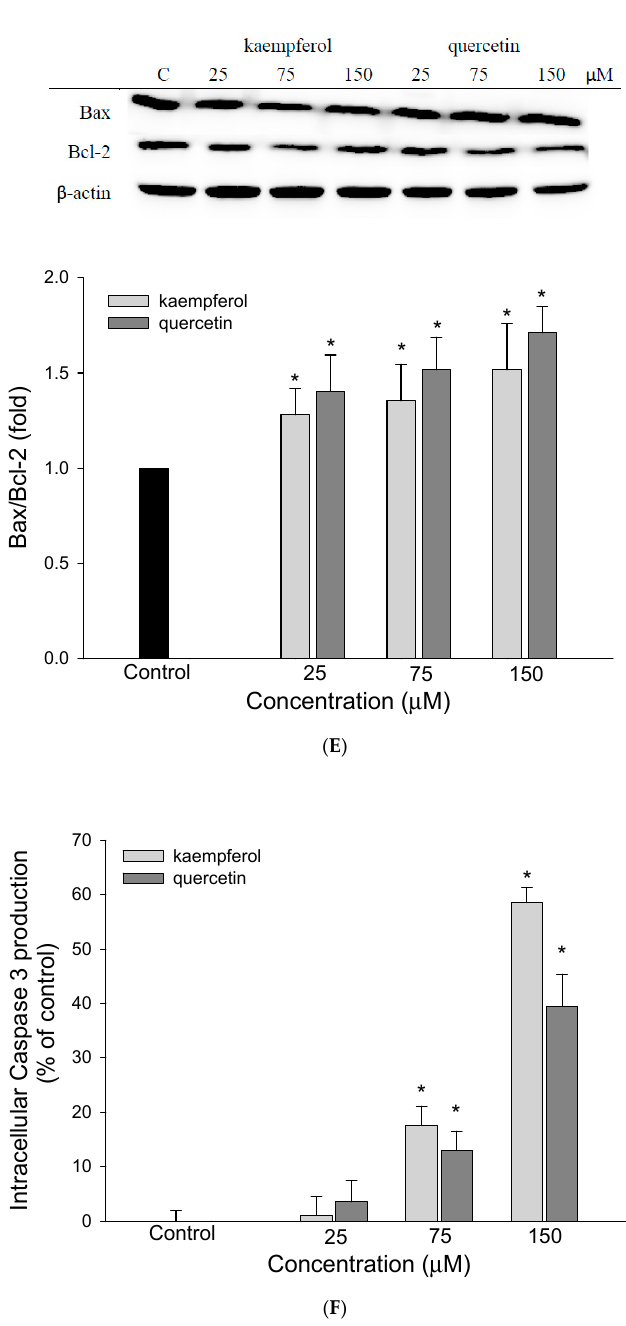
Figure 4. The effect of kaempferol and quercetin on cell viability and apoptotic effect of HepG2 cells. ( A ) Effect of kaempferol or quercetin on cell viability was determined by MTT assay. ( B ) Effect of kaempferol or quercetin on cell disruption was determined by lactate dehydrogenase (LDH) leakage assay. The results are expressed as percent of LDH activity in the culture medium relative to the total enzyme activity. ( C ) Chromatin condensation was determined by DAPI staining after kaempferol or quercetin treatment. The DAPI-stained cells were evaluated using fluorescence microscopy (200 × ). The arrow indicated apoptotic cells. ( D ) E ff ect of kaempferol or quercetin on mitochondrial membrane potential in HepG2 cells. ( E ) E ff ect of kaempferol or quercetin on Bax / Bcl-2 ratio in HepG2 cells. ( F ) E ff ect of kaempferol or quercetin on caspase-3 activity in HepG2 cells. The cells were incubated with kaempferol or quercetin for 72 h ( A ), 72 h ( B ), 72 h ( C ), 24 h ( D ), 24 h ( E ), and 48 h ( F ), respectively. The data are expressed as the mean ± SD ( n = 3). * indicated significant di ff erence from the control ( p <